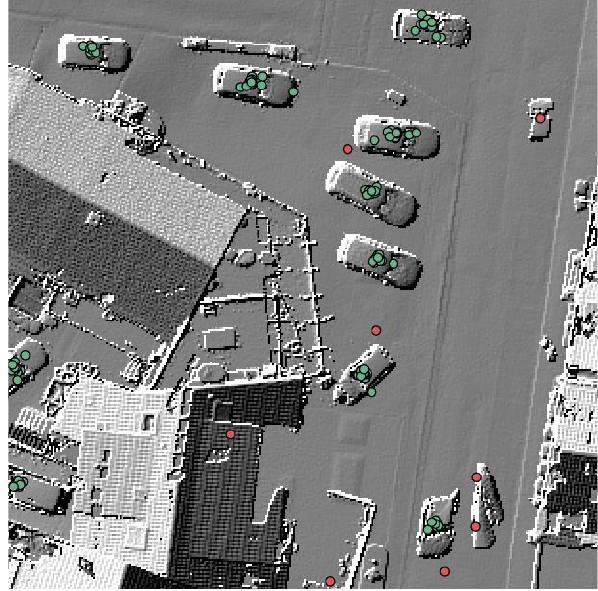
Figure 4. Collected centres ( x - and y -position) of the vehicles for an exemplary subset of the test area. Outliers detected with DBSCAN are marked with red colour